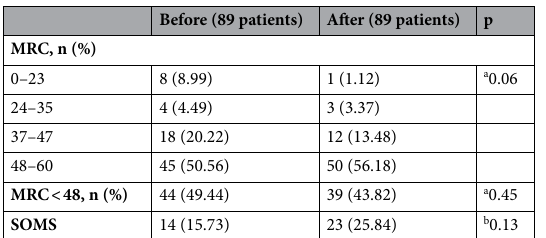
Table 4. ICU-AW. MRC Medical Research Council Scale, SOMS Surgical Intensive Care Unit Optimal Mobilisation Score. a Pearson chi-square, b Fisher.